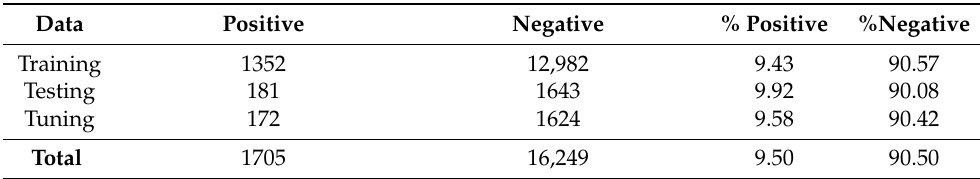
Table 2. Dataset